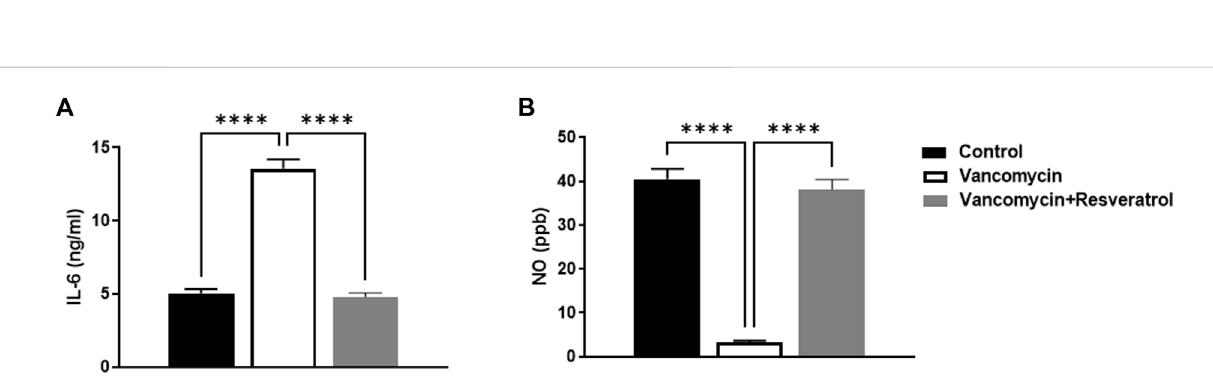
FIGURE 2 Interleukin-6 (IL-6) levels in ng/ml and (B) nitric oxide (NO) levels in parts per million (ppb) were measured in the control rats, rats injected with vancomycin only, and rats injected with vancomycin and resveratrol. Signi fi cant difference: **** p < 0.0001.